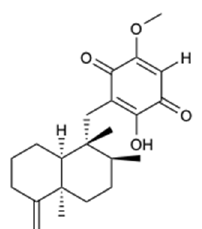
Figure 11. Structure of epi-ilimaquinone ( 38 ).